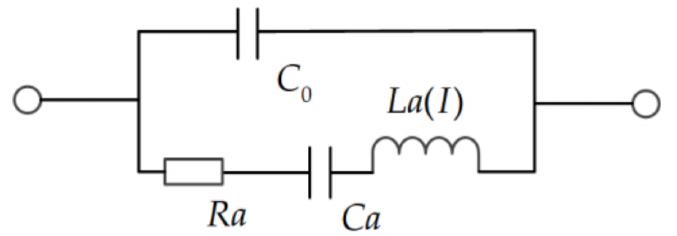
Figure 2. The schematic diagram of nonlinear BVD